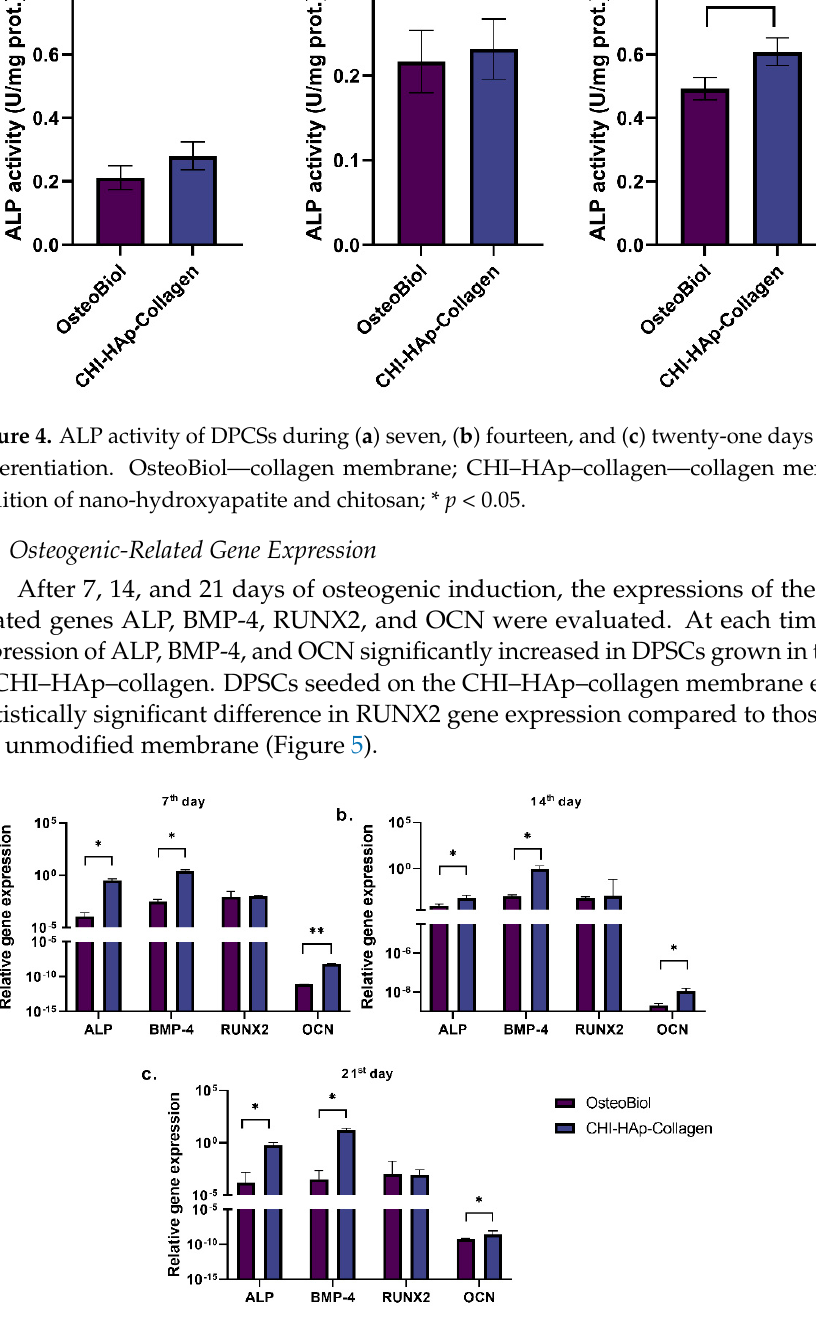
Figure 5. Relative expression of ALP, BMP-4, RUNX-2, and OCN genes during ( a ) seven, ( b ) four- teen and ( c ) twenty-one days of osteogenic differentiation. OsteoBiol—collagen membrane; CHI– HAp–collagen—collagen membrane with addition of nano-hydroxyapatite and chitosan; * p < 0.05, ** p <